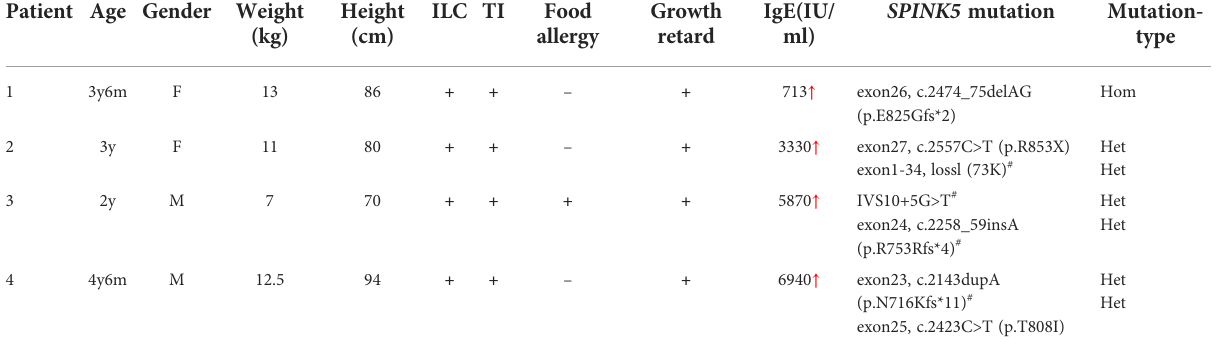
TABLE 1 Clinical and genetic characteristics of the patients with Netherton